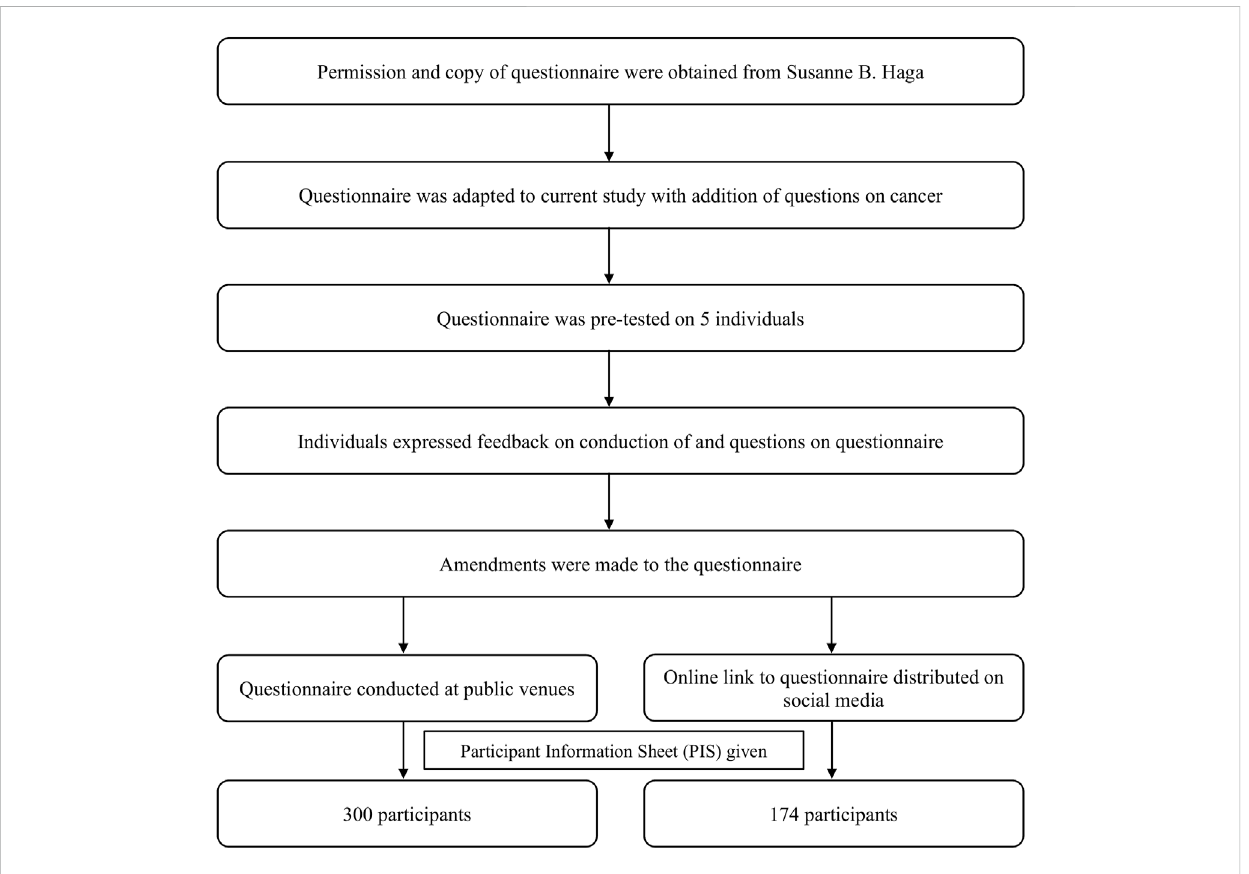
FIGURE 1 Flow chart of study materials and